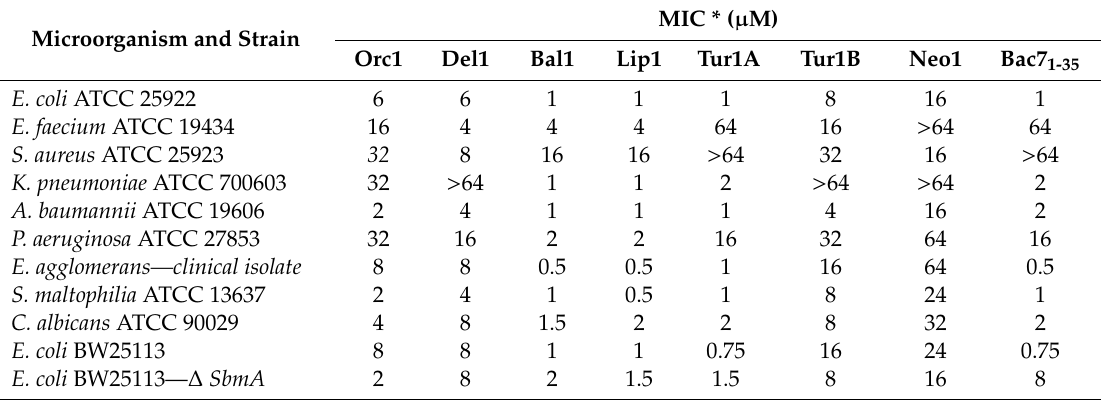
Table 2. MIC values for cePrAMPs, compared to bovine Bac7(1-35), against a panel of reference pathogenic bacterial and fungal